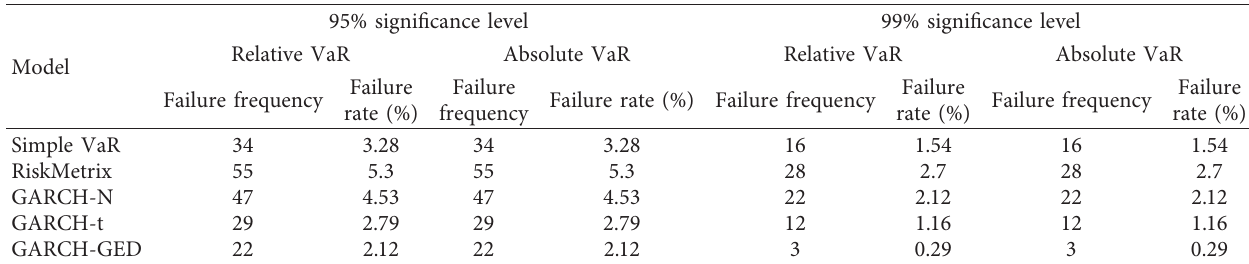
Figure 9: The VaR value overlay of the three models. Table 7: Back-testing